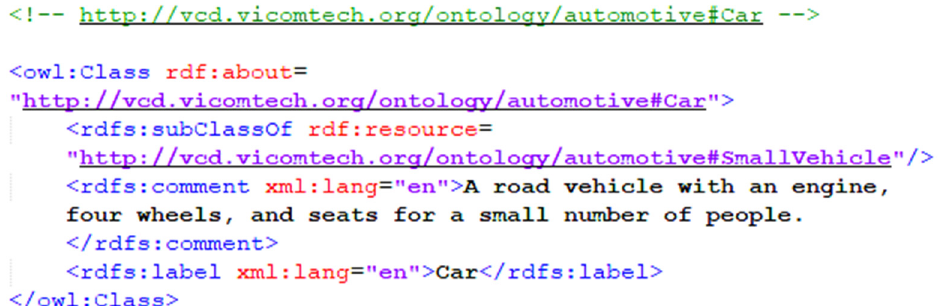
Figure 2. Example of an AGO Class definition in OWL.